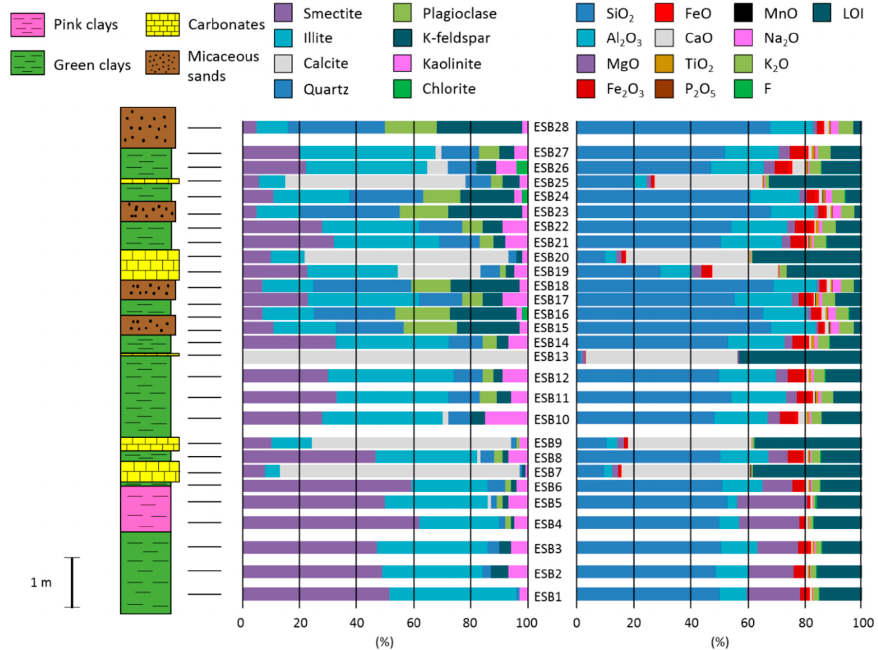
Figure 2. Schematic stratigraphic column of the succession along with the location of the samples, mineral content (%) and major element composition in weight percentage.